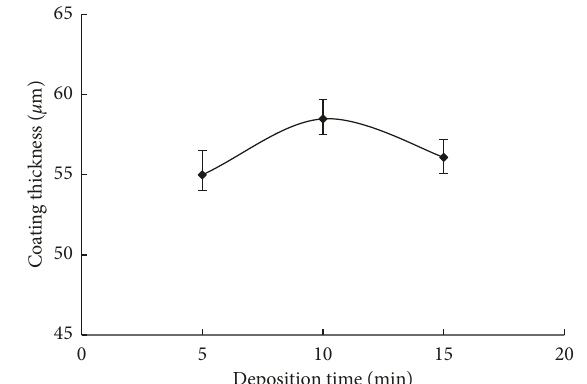
Figure 9: Effect of deposition time on coating thickness (the pipe diameter of the electrode is Φ 2.0, and the capacitance is the 3rd